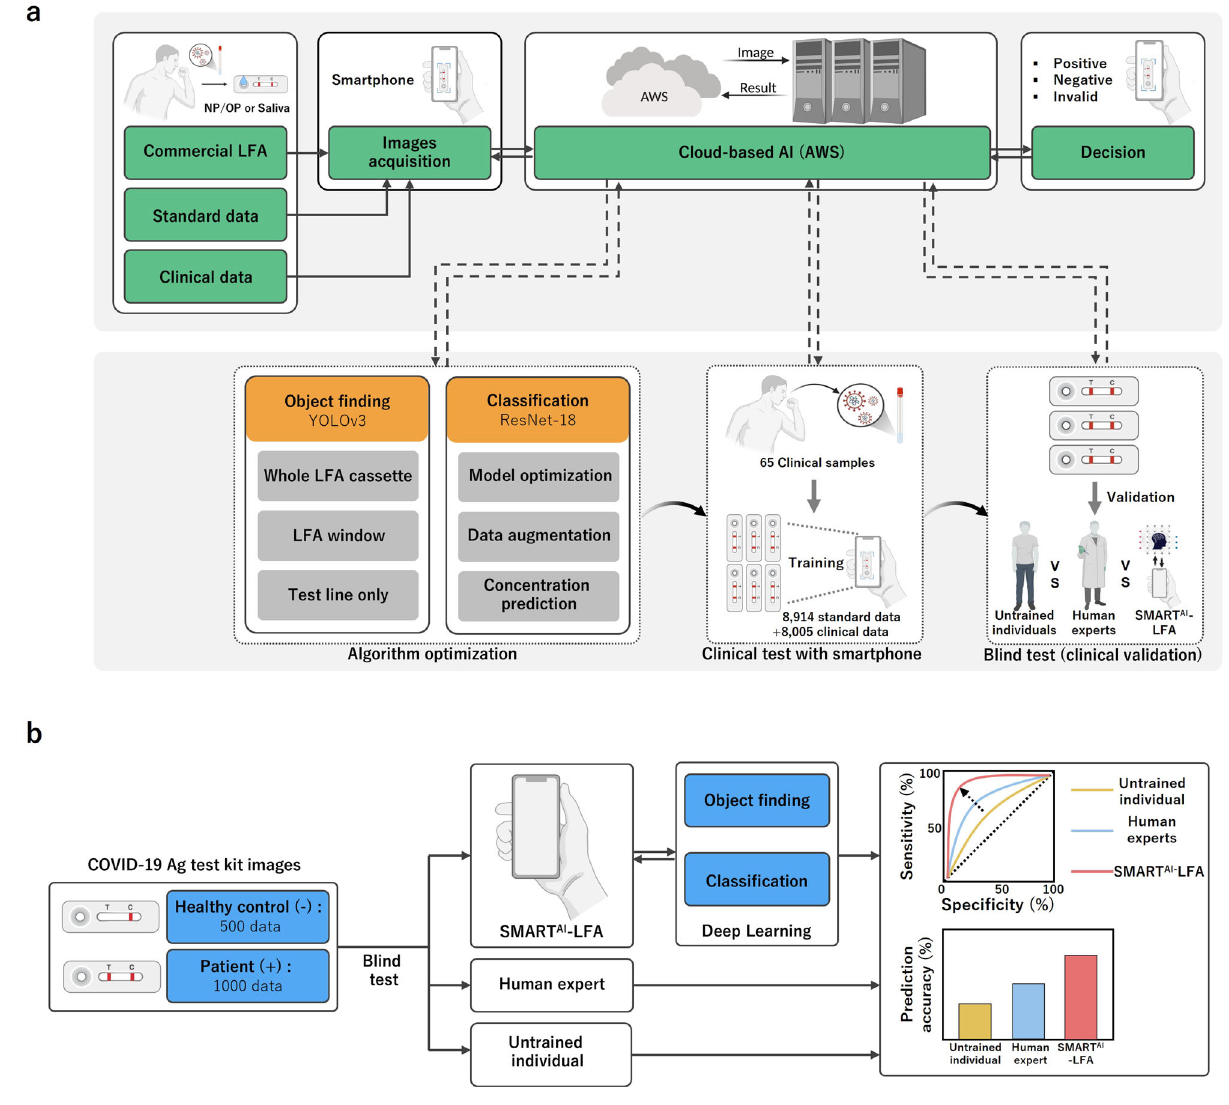
Fig. 1 | Work fl ow of SMART AI -LFA for COVID-19 diagnostics. a Experimental design of SMART AI -LFA, enabling sample-to-answer for COVID-19 with the aid of deep learning-assisted determination. The architecture mainly consists of object fi nding and binary classi fi cation, which are trained over the dataset containing